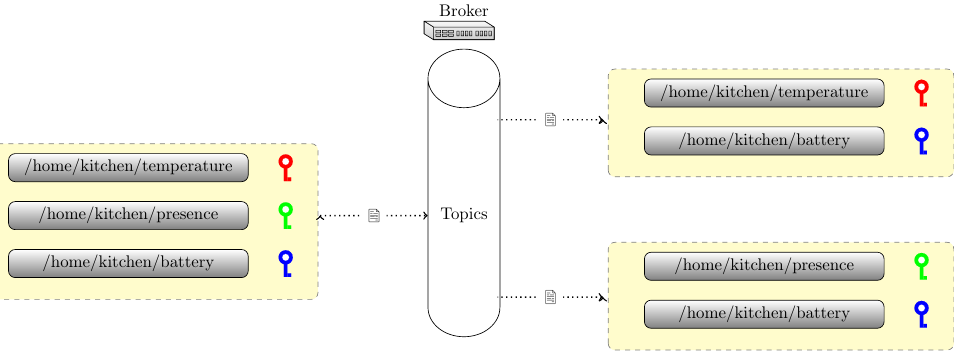
Figure 1. The broker in MQTT routes messages between groups of publishers and